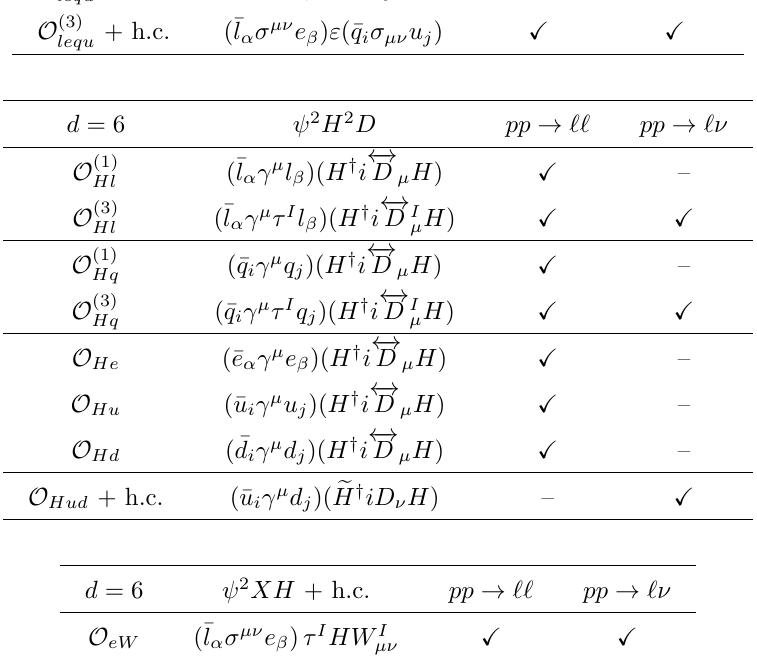
to O to conveniently have lepton- qe eq